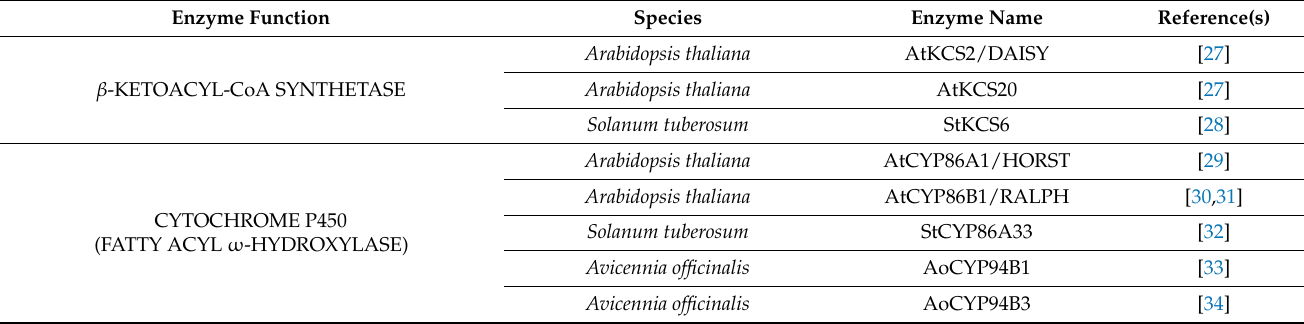
Table 1. List of genes/enzymes that were functionally characterized in the suberin pathway. Genes/enzymes are listed according to their order of appearance in the main